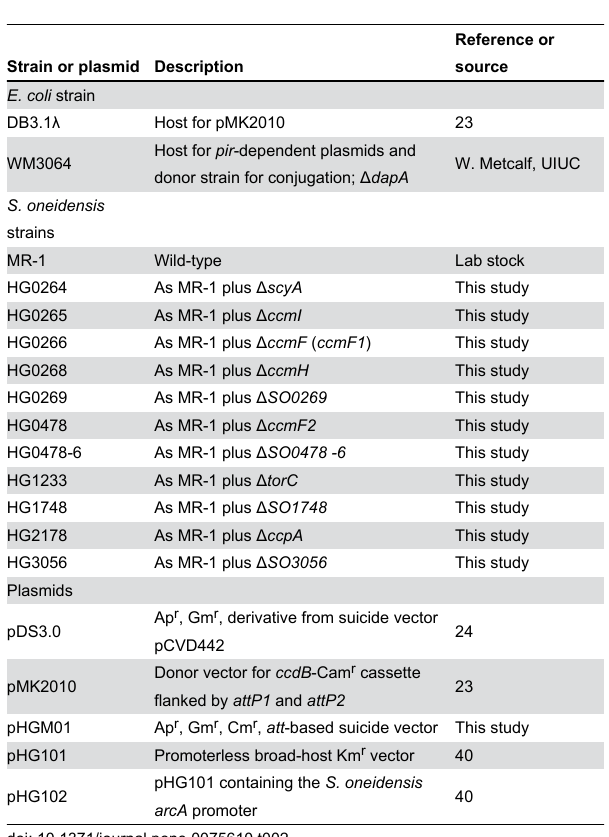
Table 2. Strains and plasmids used in this study.